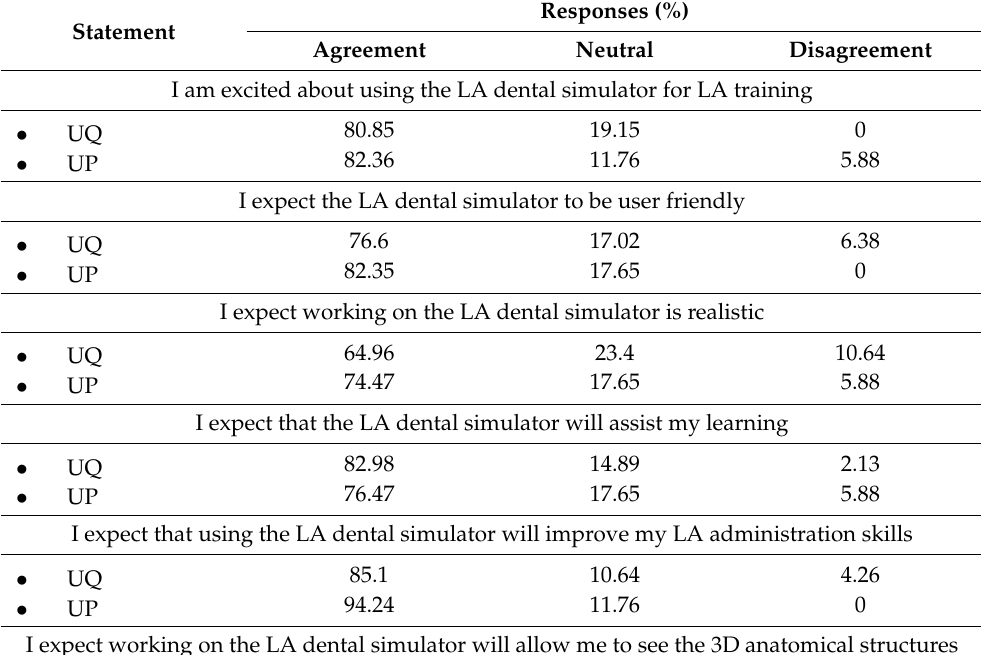
Table 1. Pre-training perceptions of dental students.